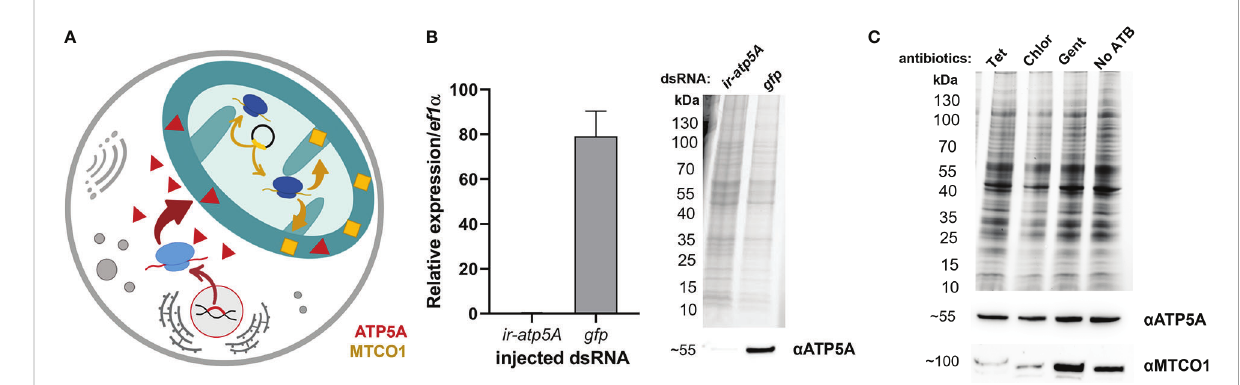
FIGURE 2 (A) A scheme depicting two distinct genomic origins of mitochondrial proteins, one from the nuclear gene (red) and one from mitochondria (yellow). (B) Validation of anti-ATP5A antibody by transcript knockdown of ir-atp5a using RNAi. RT-qPCR on cDNA from ovaries (left) and Western blotting on protein homogenates of ovaries (right) from fully engorged I. ricinus females are shown. (C) Western blot analysis detecting two mitochondrial proteins ATP synthase subunit alpha (ATP5A) and Mitochondrially Encoded Cytochrome C Oxidase I (MTCO1) in a homogenate of tick cells. Tet, Tetracyclin; Chlor, Chloramphenicol; Gent, Gentamicin; No ATB, no antibiotics. (B, C) Proteins were separated using reducing SDS-PAGE and visualized by the stain-free system (BioRad). Below, western blot analyses are shown using commercial antibodies against ATP5A ( a ATP5A) and MTCO1 ( a